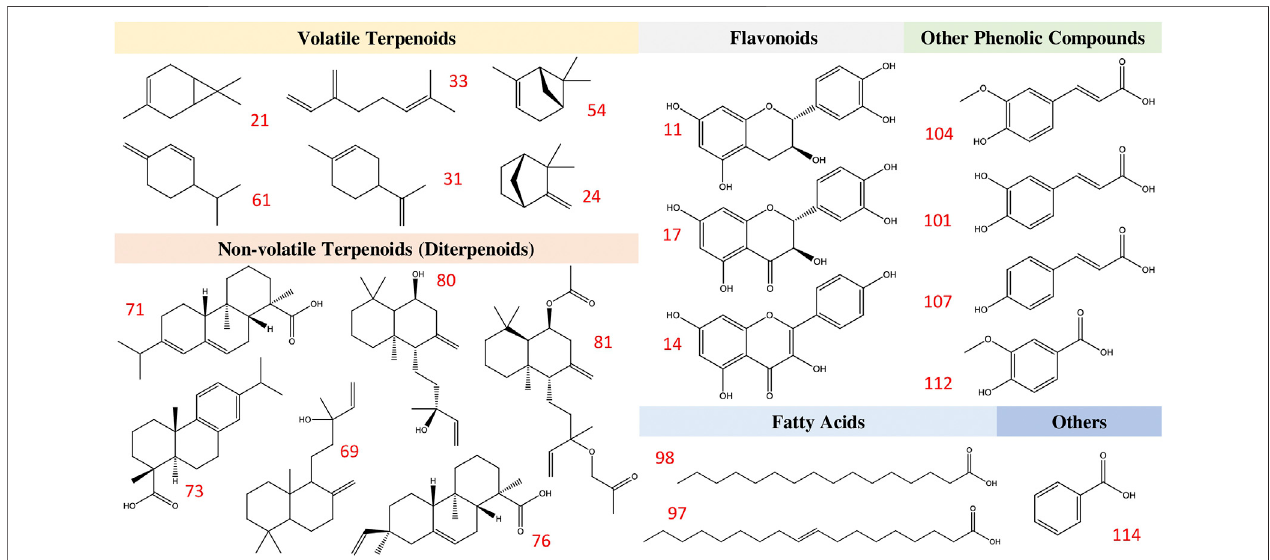
FIGURE 3 | Phytochemical classes and their selected compounds identi fi ed in L. decidua Mill [Pinaceae].